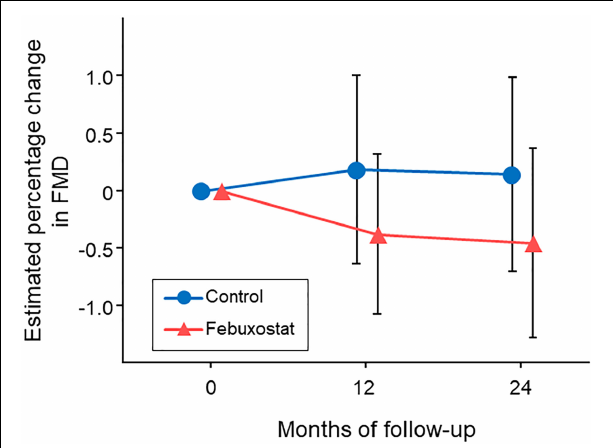
FIGURE 2 | Changes in estimated percentage change in flow-mediated vasodilation (FMD) in the febuxostat group and the control group. The mixed-effects model included treatment, follow-up time, a treatment × follow-up time interaction term, age, sex, serum uric acid levels at each time point, and FMD at baseline.